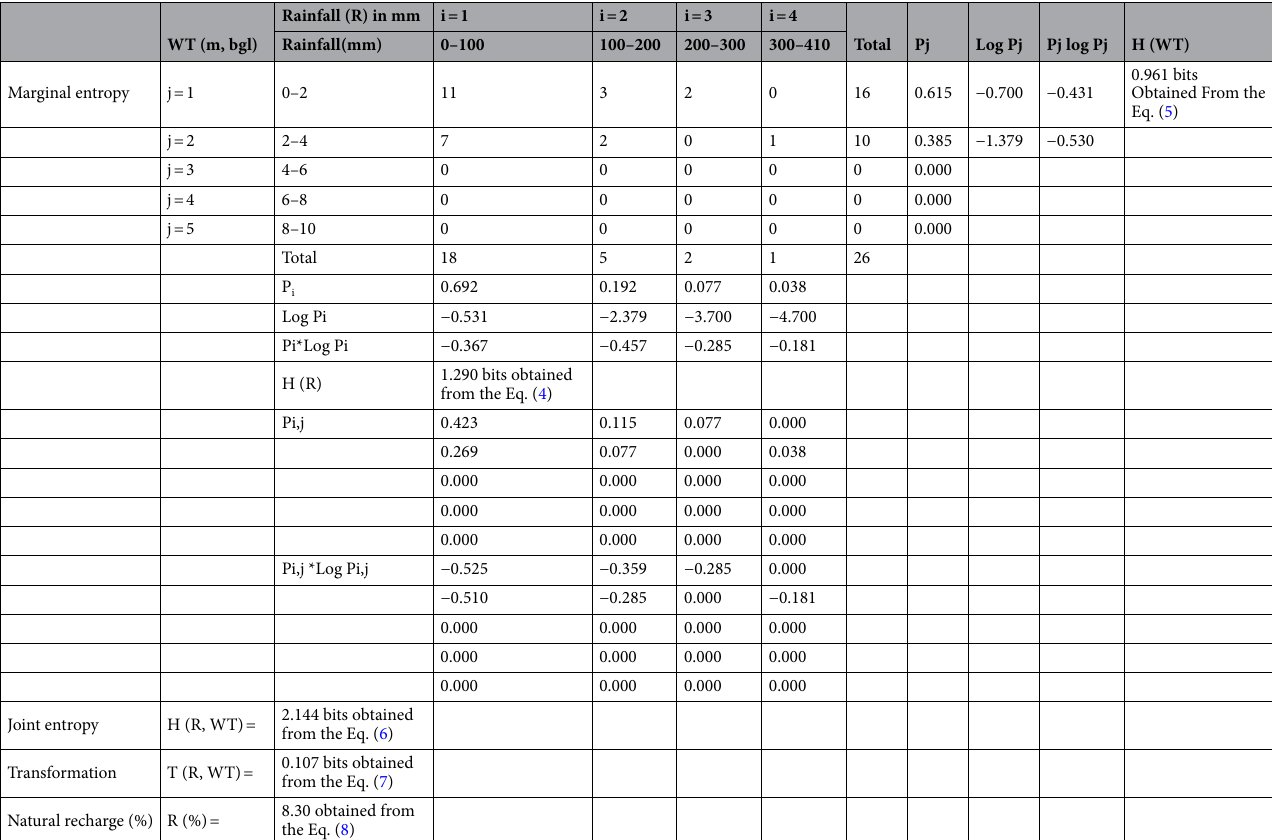
Table 1. Absolute frequency 2-D contingency table for rainfall (R in mm) and depth to water table (WT, m, bgl) at well W 42 (village: Tishkhora) located in the flood plain of a morphodynamic system in a part of the Ganga basin of Northern